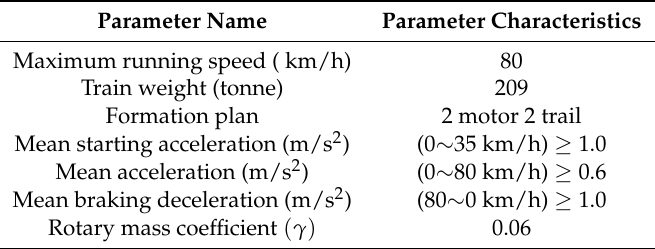
Table 3. The attributes for the train of Jinpu line 1.